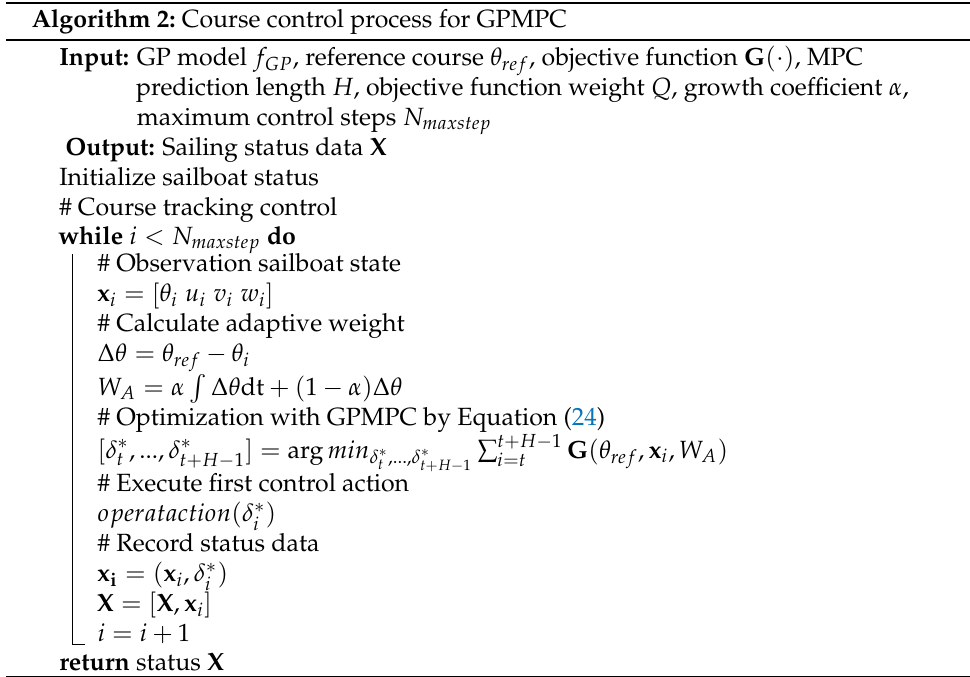
Algorithm 2: Course control process for